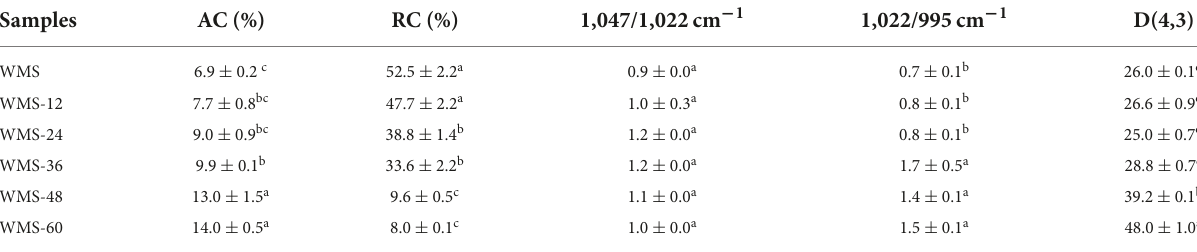
TABLE 2 The amylose content, crystallinity, Fourier transform infrared (FTIR), and particle size of native and fermented starch.